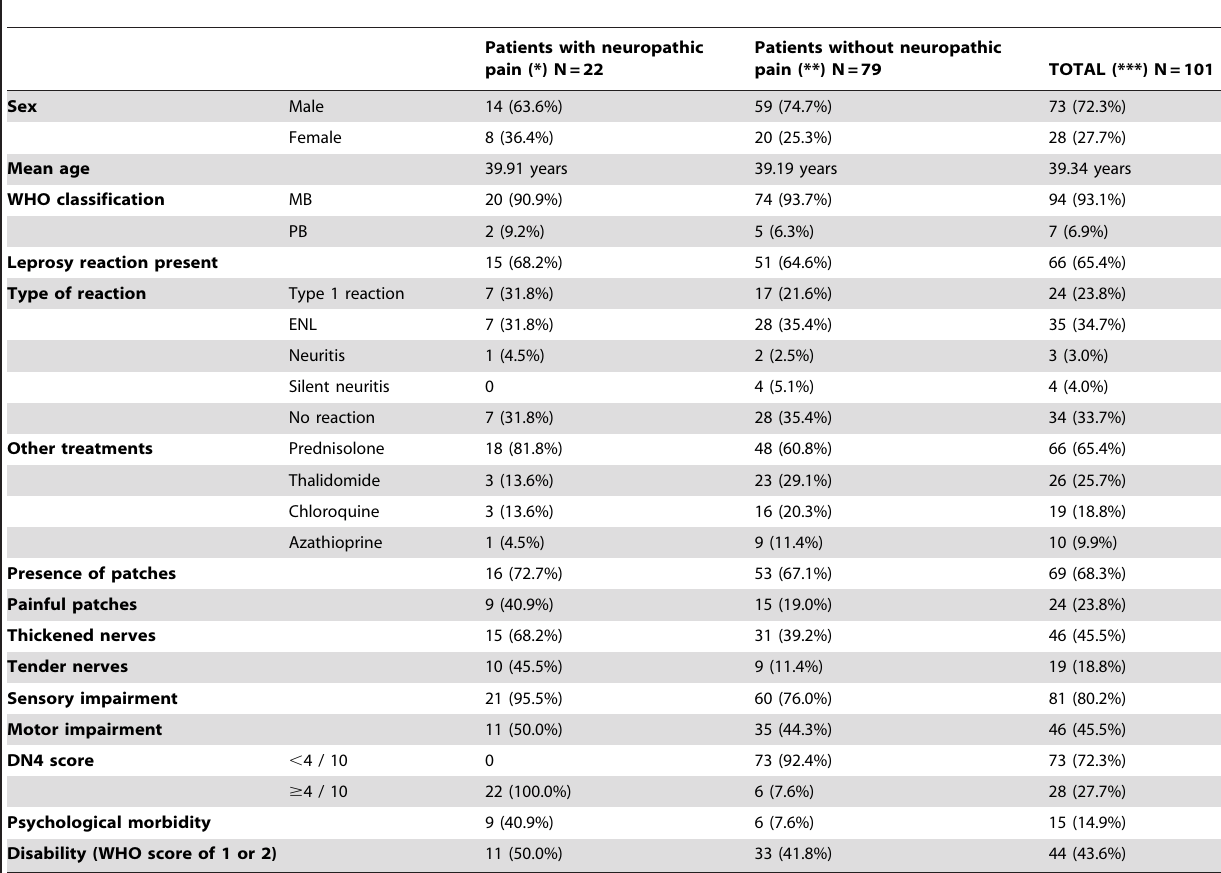
Table 1. Patient characteristics according to presence or absence of neuropathic